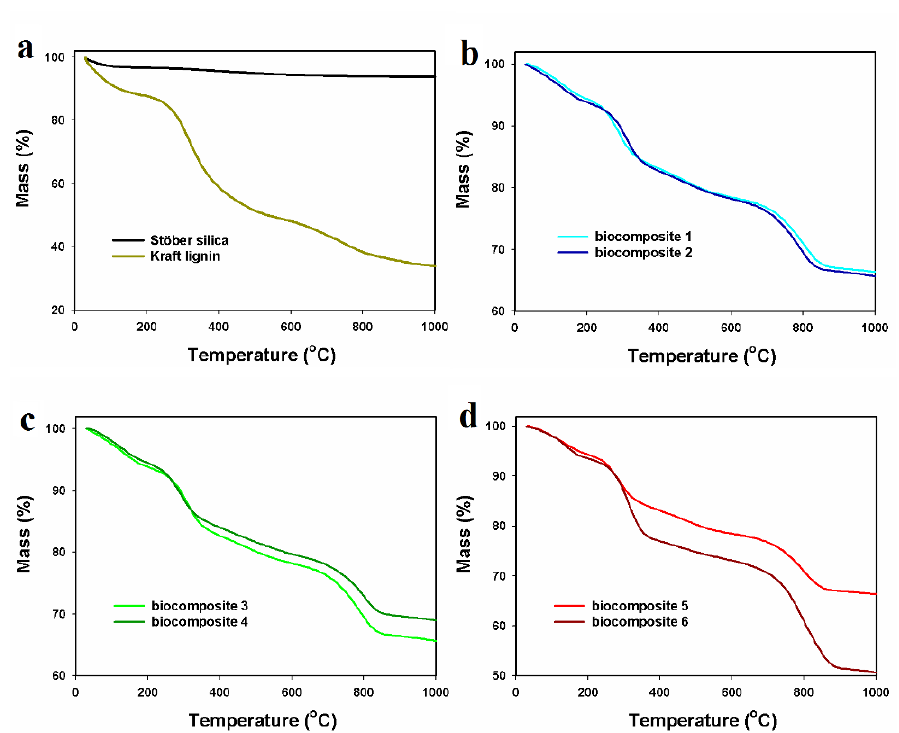
Figure 8. Thermal analysis of (a) silica and Kraft lignin, (b) silica/lignin biocomposites obtained by method I, (c) method II, and (d) method